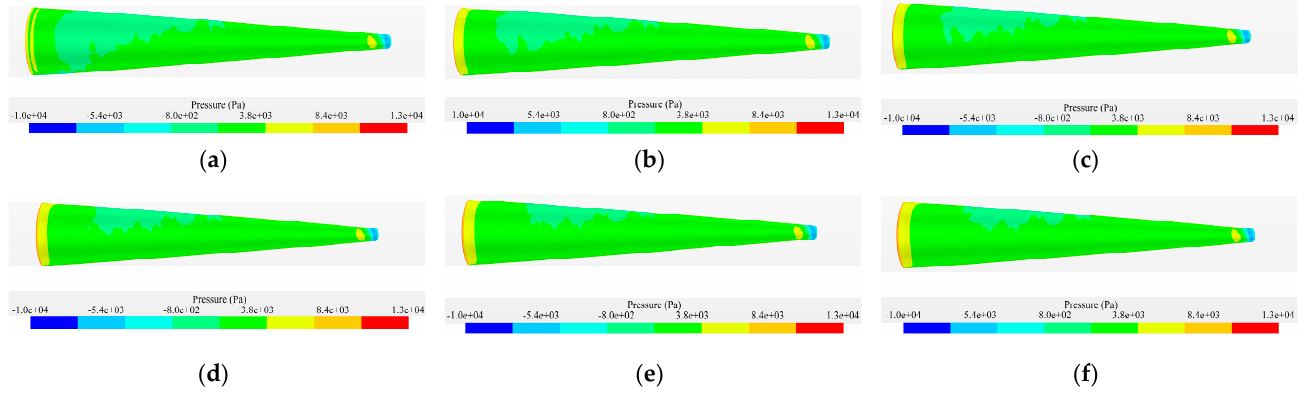
Figure 20. Pressure distribution of A1 with the air injected from the location L2: ( a ) Without air injection; ( b ) Air fl ow rate Q = 8 L/s; ( c ) Air fl ow rate Q = 12 L/s; ( d ) Air fl ow rate Q = 16 L/s; ( e ) Air fl ow rate Q = 20 L/s; ( f ) Air fl ow rate Q = 24 L/s.